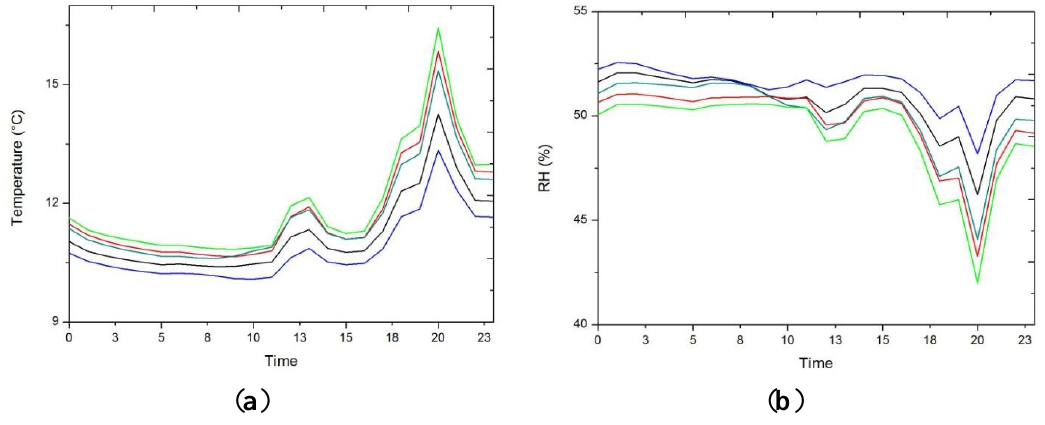
Figure 9. Mean daily trajectories, for days when the heating system is switched on, of the average of sensors at the back (black), the average of sensors at the front (red), the average of sensors at low height (blue), the average of sensors at intermediate height (green) and the average of sensors at high height (lime). ( a ) Temperature. ( b ) RH. Note the similarity between the red and lime trajectories, although softened the red one since it also includes sensors #9 and